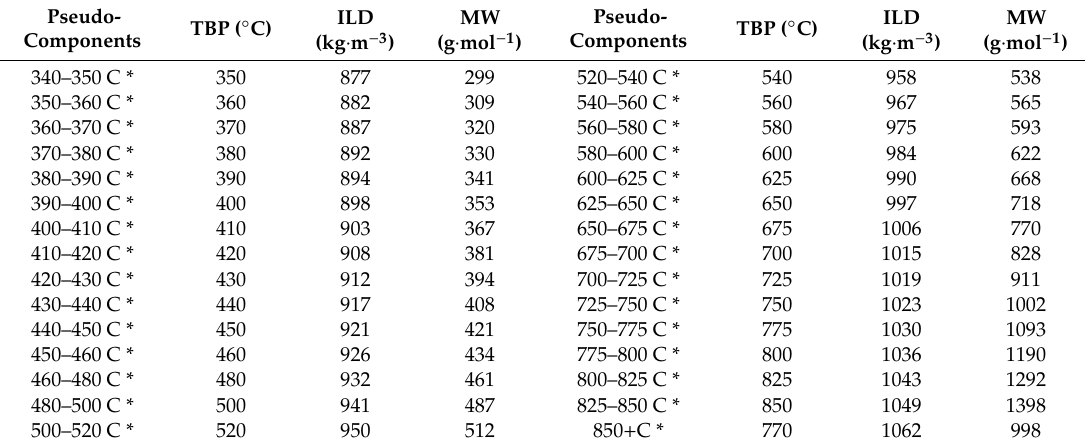
Table 4. Part of boiling point-based pseudo-components and their properties.